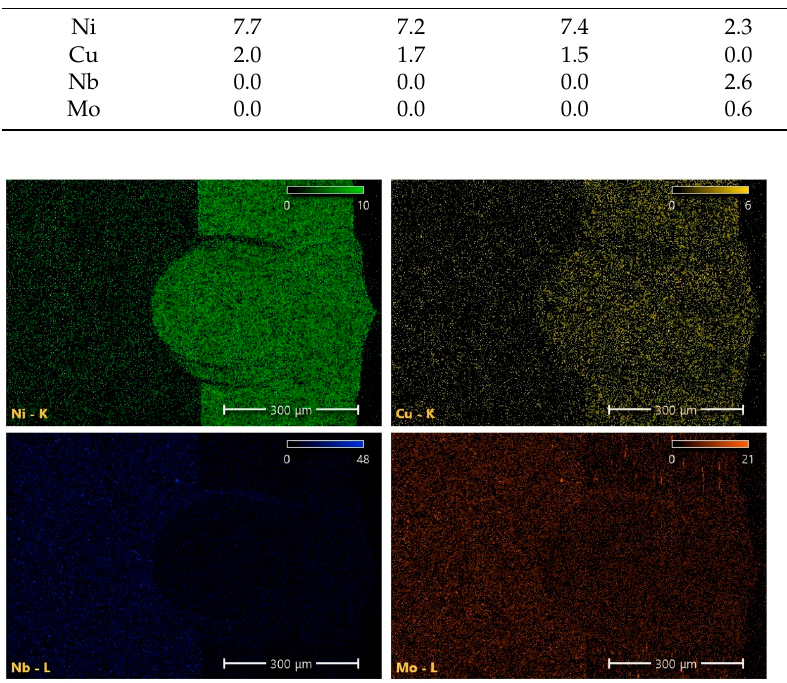
Figure 13. Element map of the weld